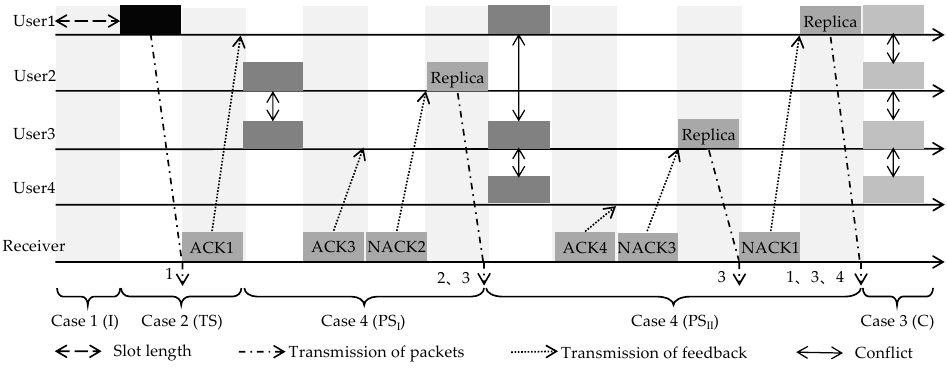
Figure 4. Standard time feedback process for system.